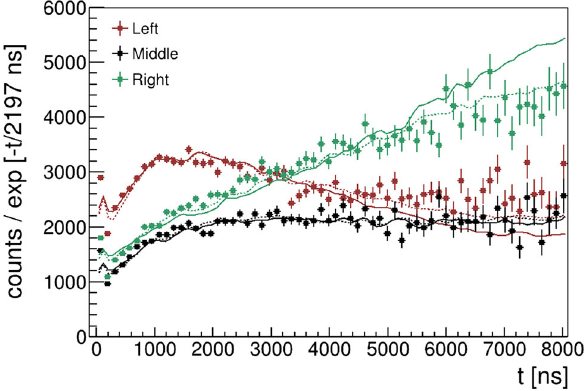
Fig. 11 Measured (dots) time spectra for the three scintillators “Left”, “Middle” and “Right”. The increase and decrease of positron counts in the “Right” and “Left” detectors, respectively, indicates that the muons are moving towards the right. Simulated time spectra for additional muon loss rate R = 0 (continuous lines) and R = 0 . 125 µ s − 1 (dashed lines) are fitted to the measured time spectra. The χ 2 for R = 0 is red 3 . 44 for 433 ◦ degrees of freedom. Introducing the additional loss rate R = 0 . 125 µ s − 1 improves the χ 2 to 2 . 23. Note that the data and red the simulations have been corrected for the finite muon lifetime by multiplying the counts with e t / 2197